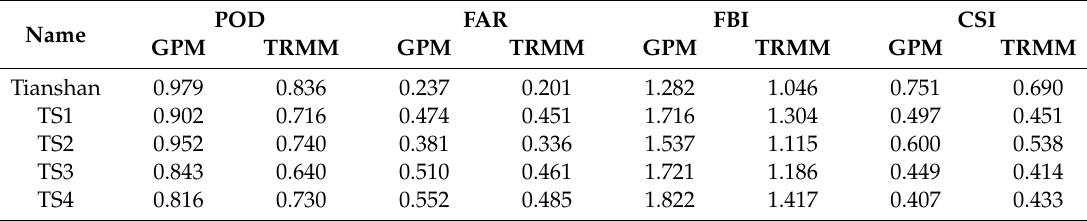
Table 3. Analysis of precipitation detection